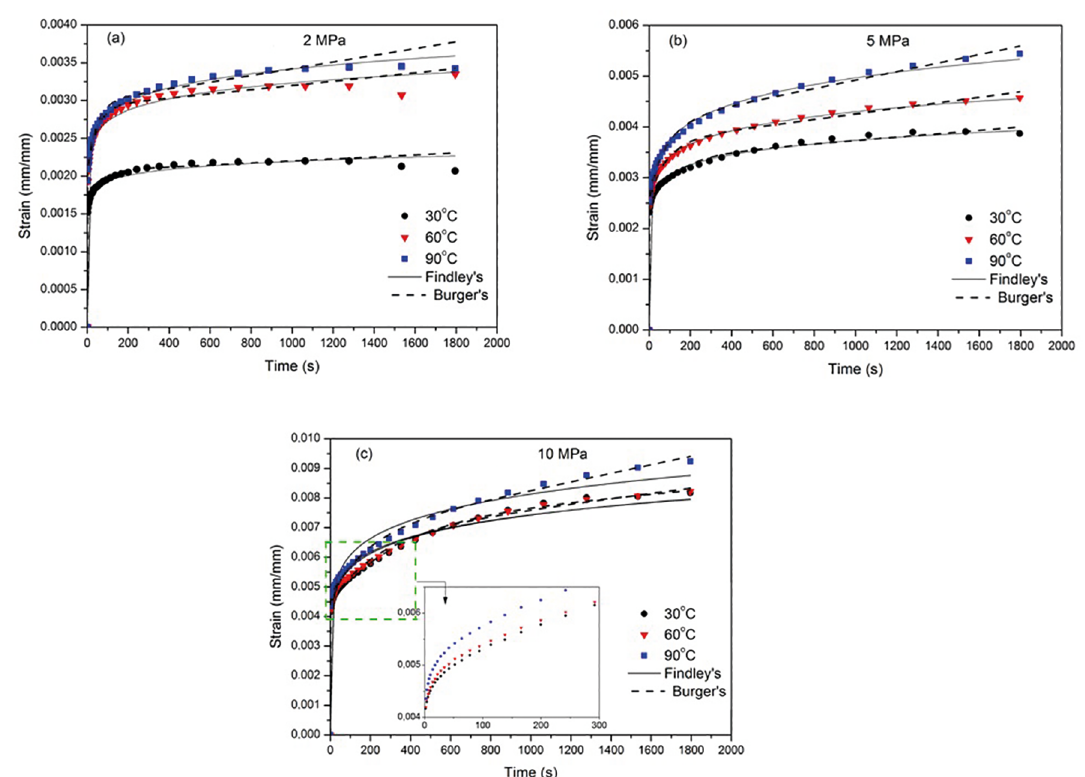
Figure 2. Creep curves and applied models of carbon NCF/epoxy composites at(a) 2 (b) 5 and (c) 10 MPa. Table 1. Findley’s parameters for carbon/epoxy NCF composite, at different stresses. Stress